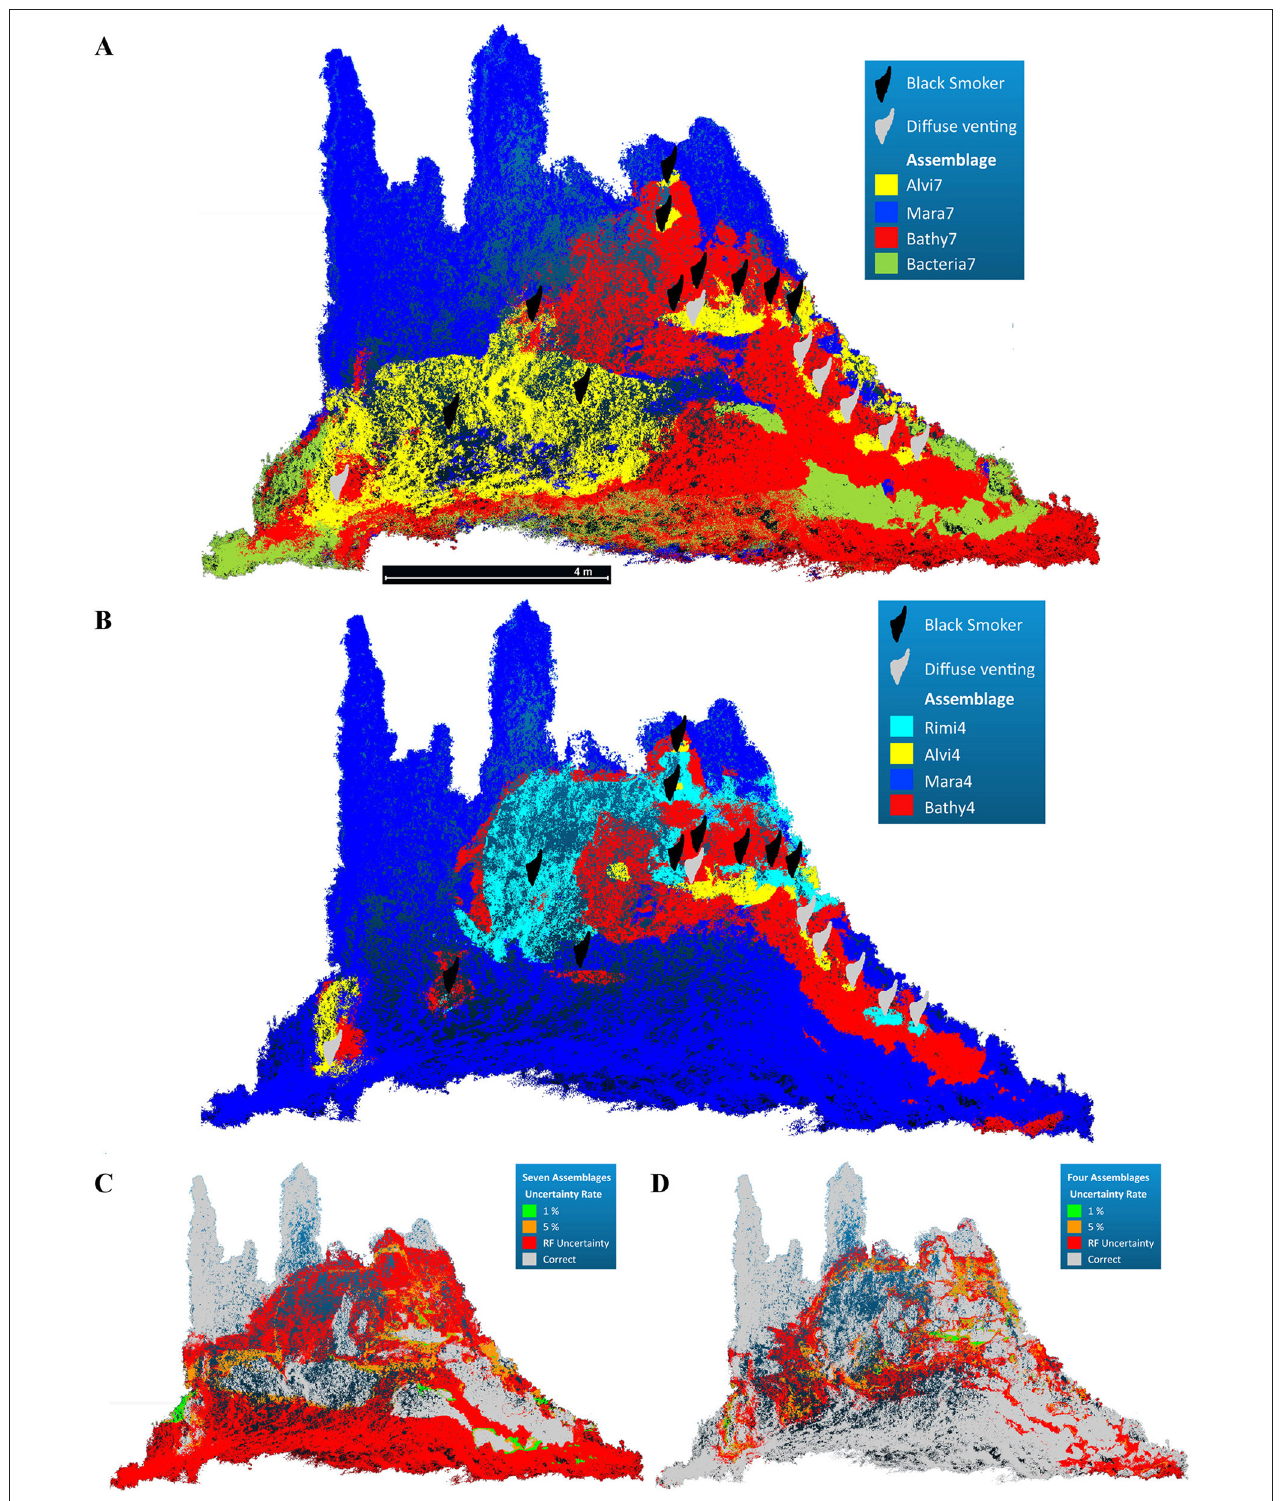
FIGURE 7 | Predicted faunal assemblage occurrence across the reconstructed chimney complex based on random forest modeling. (A) Occurrence of the seven faunal assemblages based on the winning classes of the predicted random forest model (Accuracy = 0.4405). (B) Occurrence of the four faunal assemblages based on the winning classes of the predicted random forest model (Accuracy = 0.8497). (C,D) False positive uncertainty rate at 1%, 5% and the random forest prediction uncertainty for both assemblages.